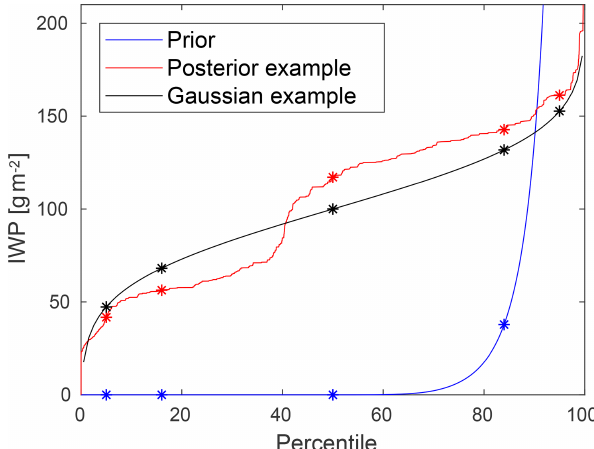
Figure 5. Example quantile functions. The blue line represents the retrieval database applied in Sect. 4.3, acting as prior for a test re- trieval (red line). For example, the prior and posterior median values are 0 and 117gm − 2 , respectively. The black line matches a hypo- thetical retrieval with a Gaussian posterior of 100 ± 32gm − 2 . The symbol * identifies the 5th, 16th, 50th, 84th and 95th percentiles of each